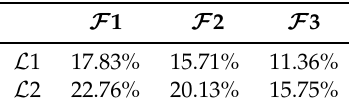
Table 4. Average WER of all test sentence output estimates obtained through 8-fold cross validation for the differently trained CNNs with respect to their respective target word class